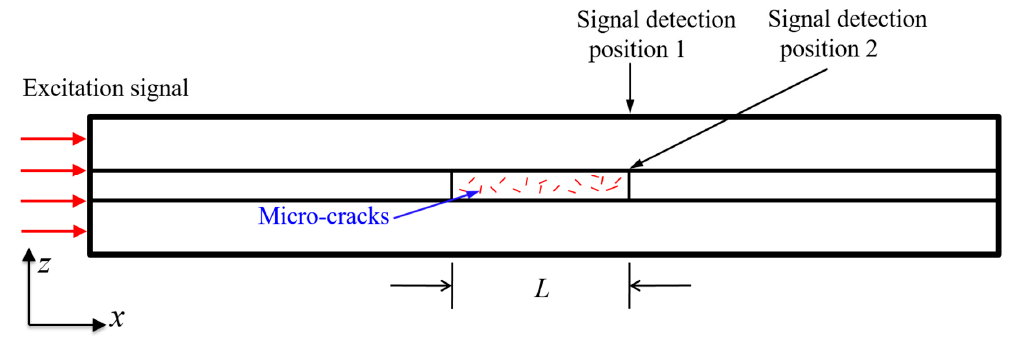
Figure 3. Schematic of the Lamb waves propagating through a region with micro-cracks for the tri-layer adhesive structure.